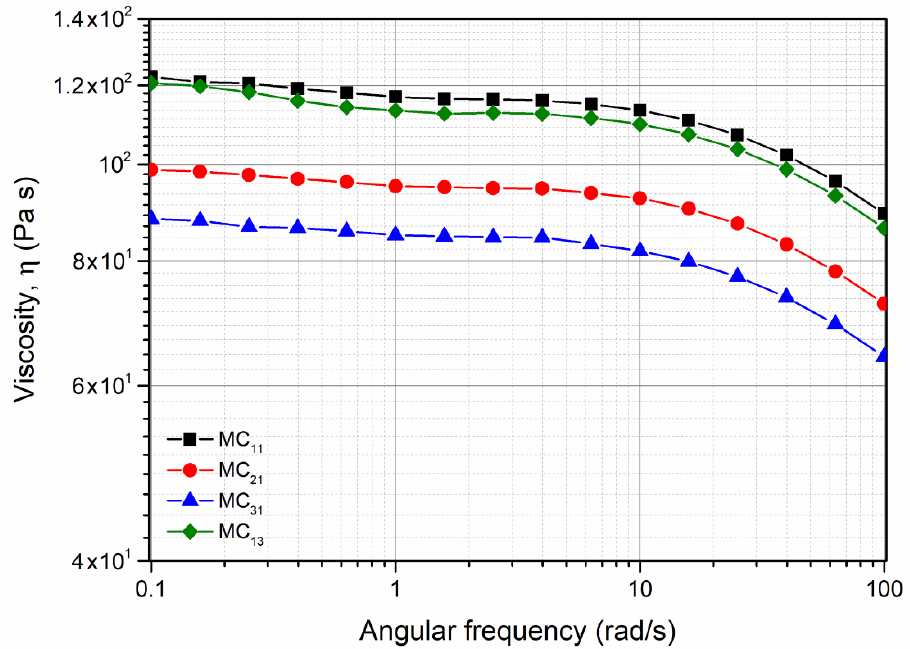
Figure 5. Flow curves of the samples from pellets conditioned under the three humidity conditions and specimen conditioned at RH = 0 and 90% after processing.